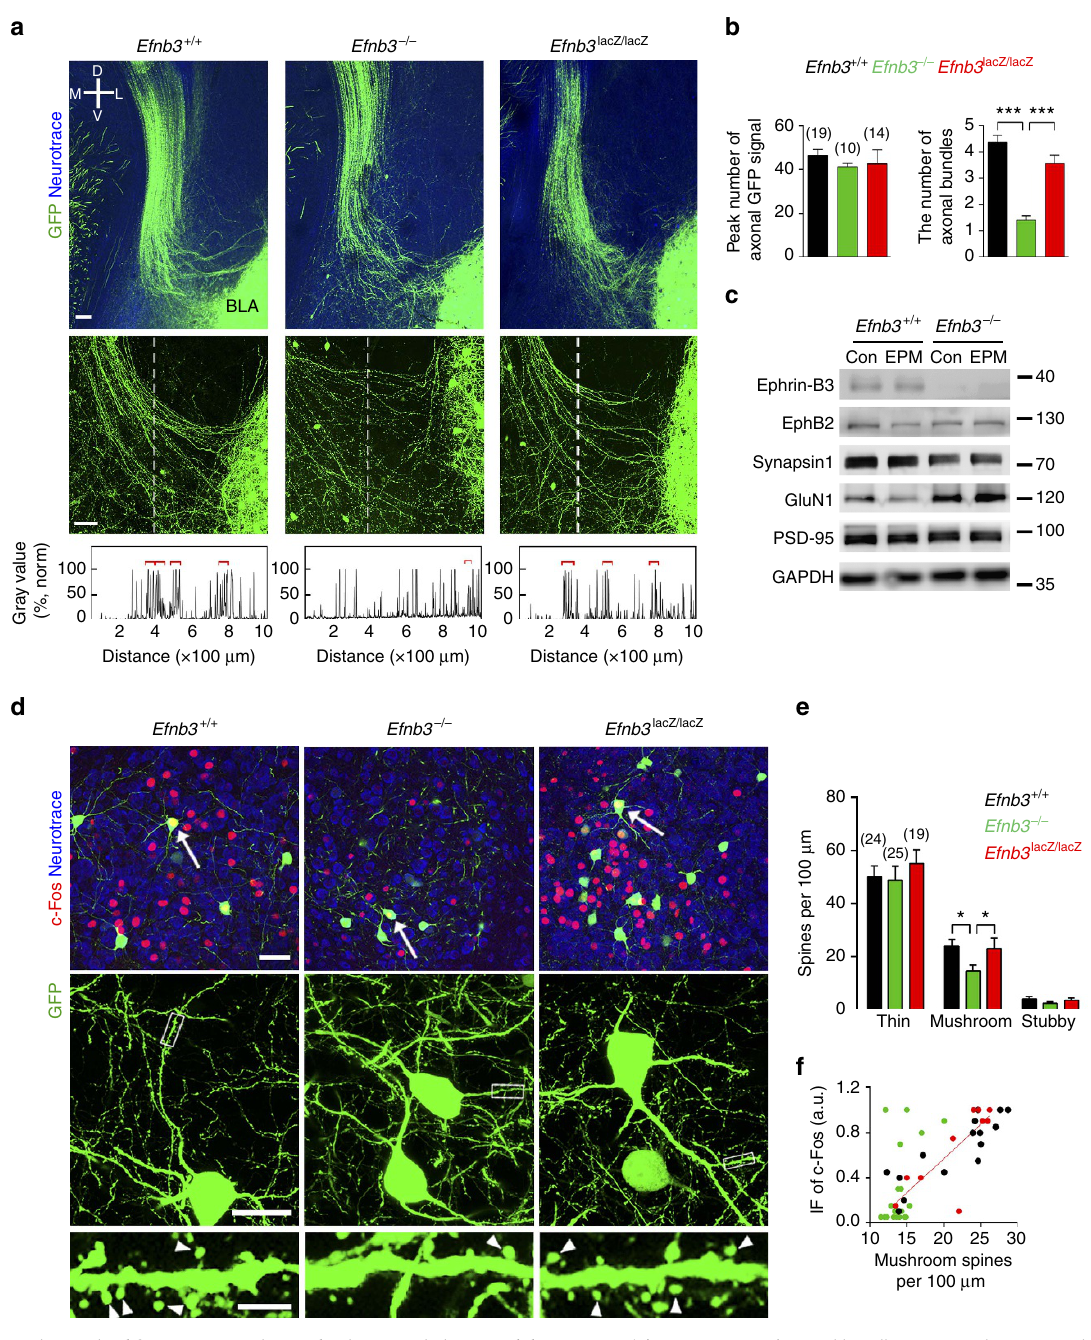
Figure 2 | eB3 is required for axon targeting and spinogenesis in amygdala neurons. ( a ) Comparison of axonal bundles projected into amygdala between Efnb3 þ / þ , Efnb3 (cid:2) / (cid:2) and Efnb3 lacZ/lacZ mice with Thy1-GFP M background. The vertical dotted line crossing the axon bundles is 1,000- m m long from top to bottom and 300 m m distance from left lateral edge of BLA. Scale bars, 100 m m. ( b ) Quantification of the total peak number of axonal signals with GFP crossing the dotted line and fasciculated axonal bundles (indicated with red square brackets). n values of brain slices from 6 to 7 mice per group are indicated above each group bar. *** P o 0.001, one-way ANOVA. ( c ) Protein expression of synaptic molecules in amygdala of Efnb3 þ / þ and Efnb3 (cid:2) / (cid:2) mice. Synapsin1 expression is downregulated, while GluN1 (NMDA receptor) is upregulated in Efnb3 (cid:2) / (cid:2) mice. ( d ) Efnb3 (cid:2) / (cid:2) but not Efnb3 lacZ/lacZ mutant mice showed delayed spine maturation and reduced c-Fos activation in BLA neurons at P16. Red is c-Fos immunofluorescence and green is the small number of random BLA neurons that are Thy1-GFP M positive and outline post-synaptic spine structures. Scale bars, 40 m m, 25 m m and 5 m m for the upper, middle and lower panels, respectively. ( e ) Quantification of density for various types of spines in WT, Efnb3 (cid:2) / (cid:2) and Efnb3 lacZ/lacZ mutant at P16. n values of neurons from 5 to 6 mice per group are indicated above each group bar. * P o 0.05, one-way ANOVA. ( f ) Correlation of the c-Fos immunofluorescence (IF) and the density of mushroom spines in c-Fos-positive neurons (left panel) in Efnb3 þ / þ , Efnb3 (cid:2) / (cid:2) and Efnb3 lacZ/lacZ mutant at P16 following EPM trial. n ¼ 15 neurons from 6 mice for Efnb3 þ / þ , r 2 ¼ 0.75; n ¼ 22 neurons from 8 mice for Efnb3 (cid:2) / (cid:2) , r 2 ¼ 0.24; n ¼ 10 neurons from 5 mice for Efnb3 lacZ/lacZ , r 2 ¼ 0.63. All the samples were from triplicated experiments.